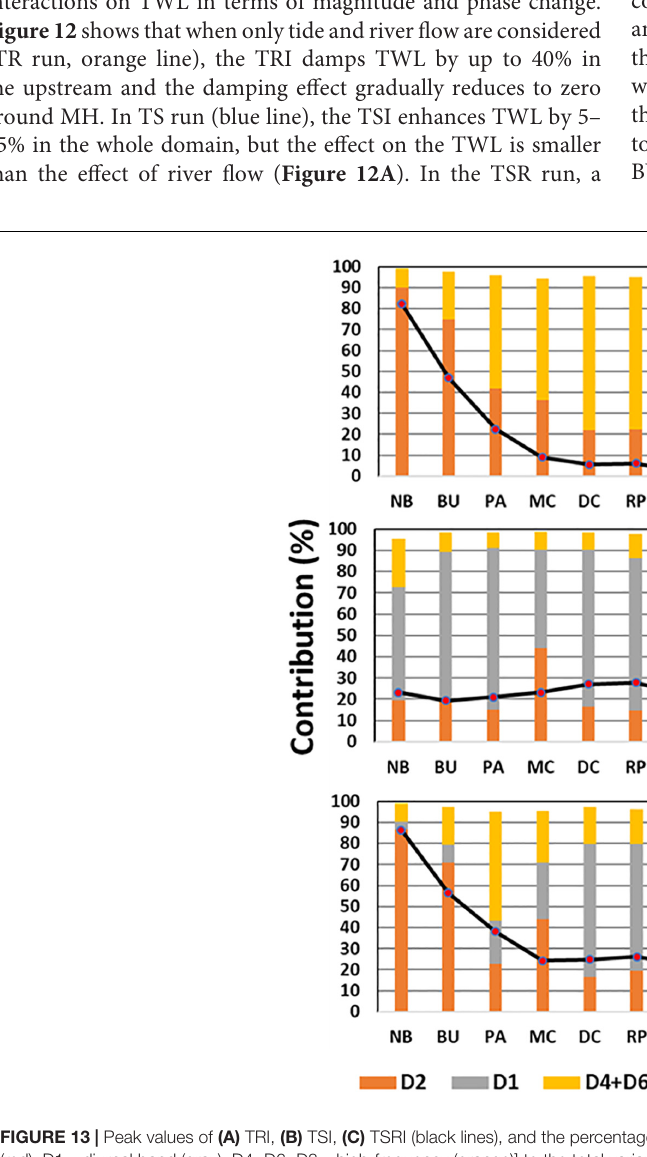
Frontiers in Marine Science |